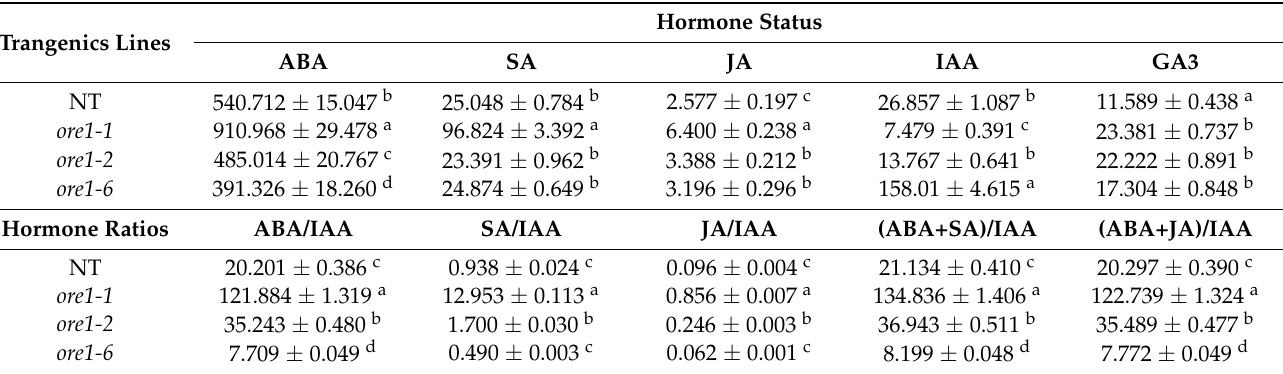
Table 1. Hormonal status in non-transgenic (NT) and soybean transgenic